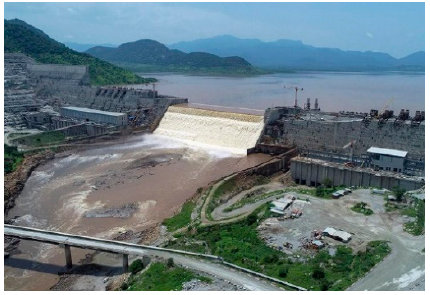
Figure 1. Grand Ethiopian Renaissance Dam on the Blue Nile.